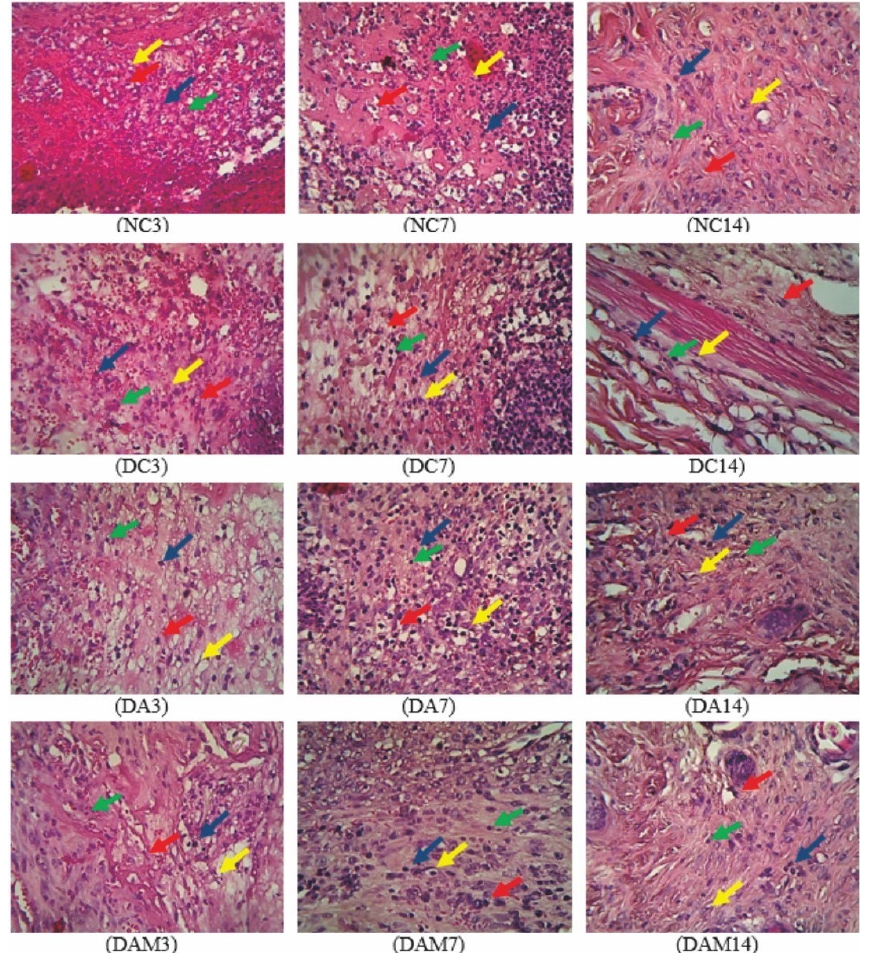
Figure 4. Analysis of wound width on the three variation times. Green arrows: neutrophils; blue arrows: macrophages; yellow arrows: fibrocytes; and red arrows: fibroblasts. NC: normal group; DA: alginate treatment group; DAM: alginate–mangosteen rind extract treatment group; and DC: diabetic group.